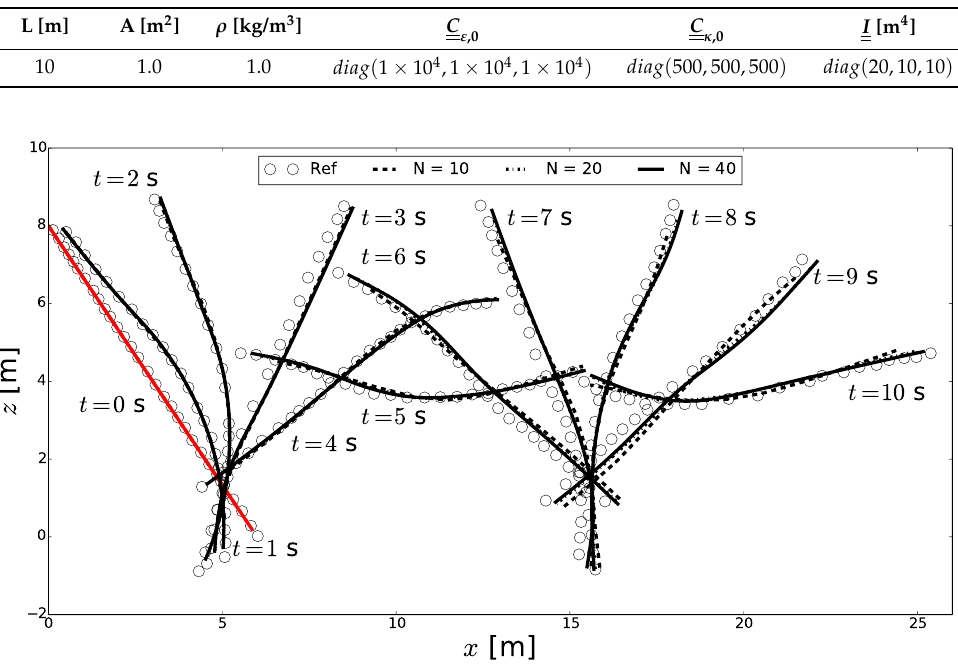
Table 3. Geometrical and material properties of the free-free rod undergoing large motions and deformations.